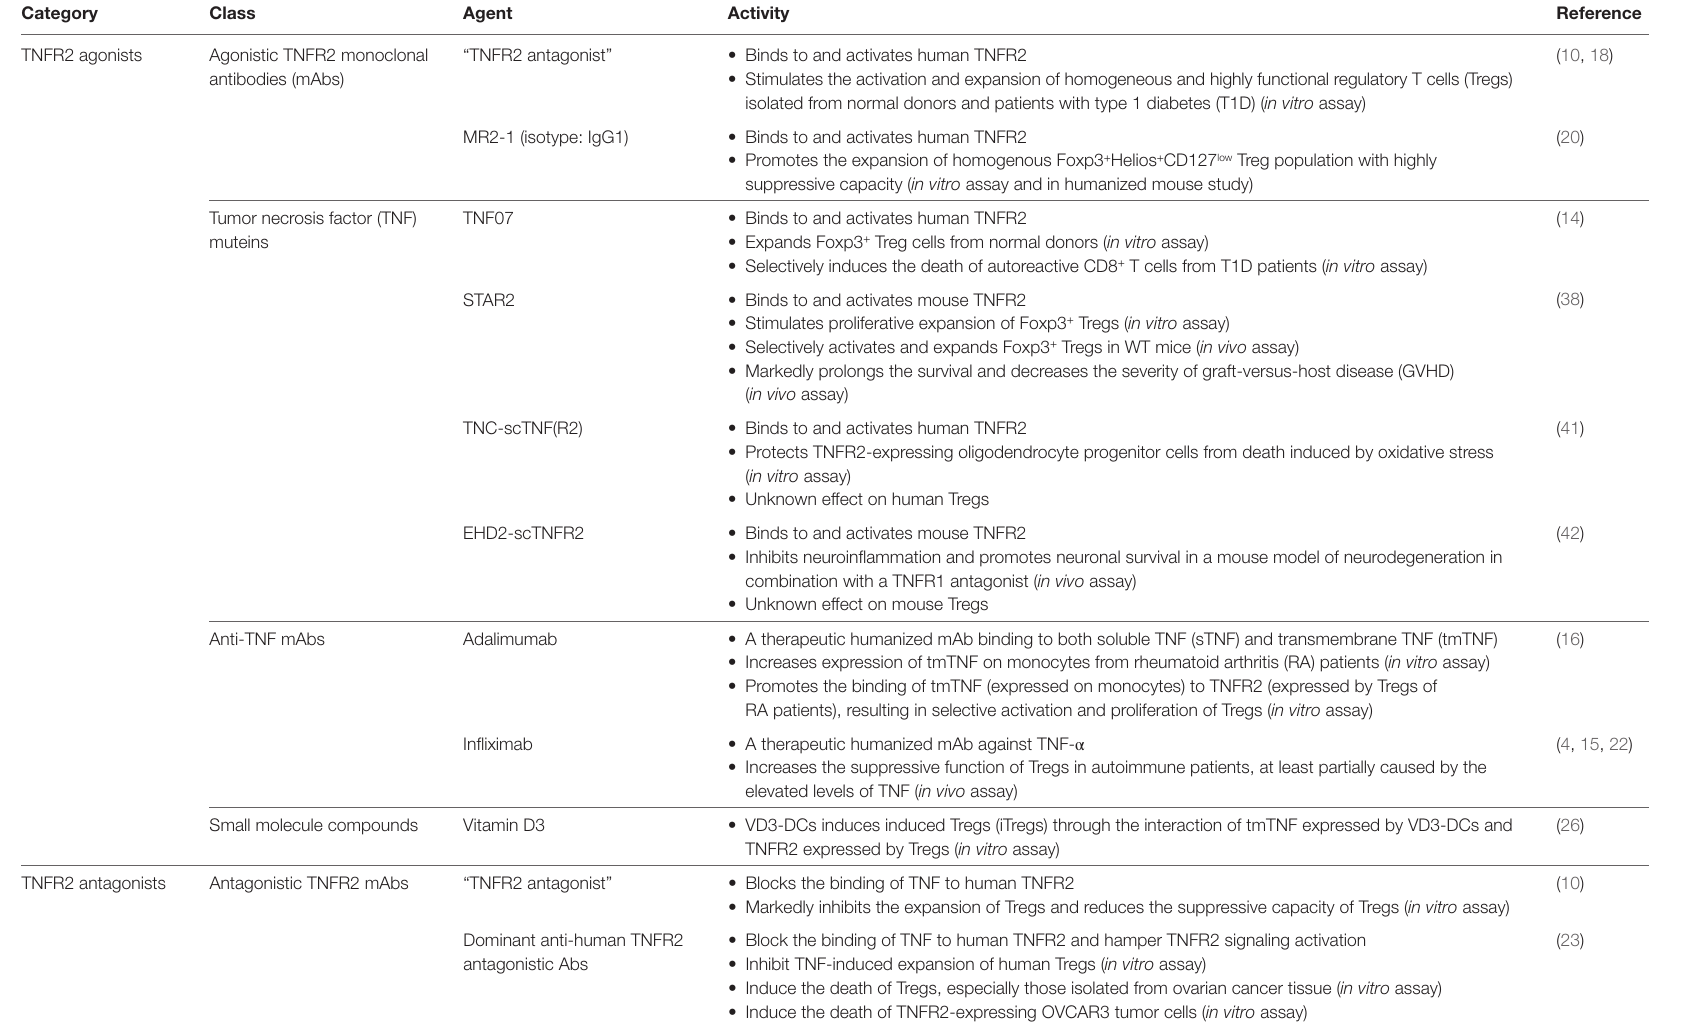
TAble 1 | TNF receptor type II (TNFR2)-targeting pharmacological